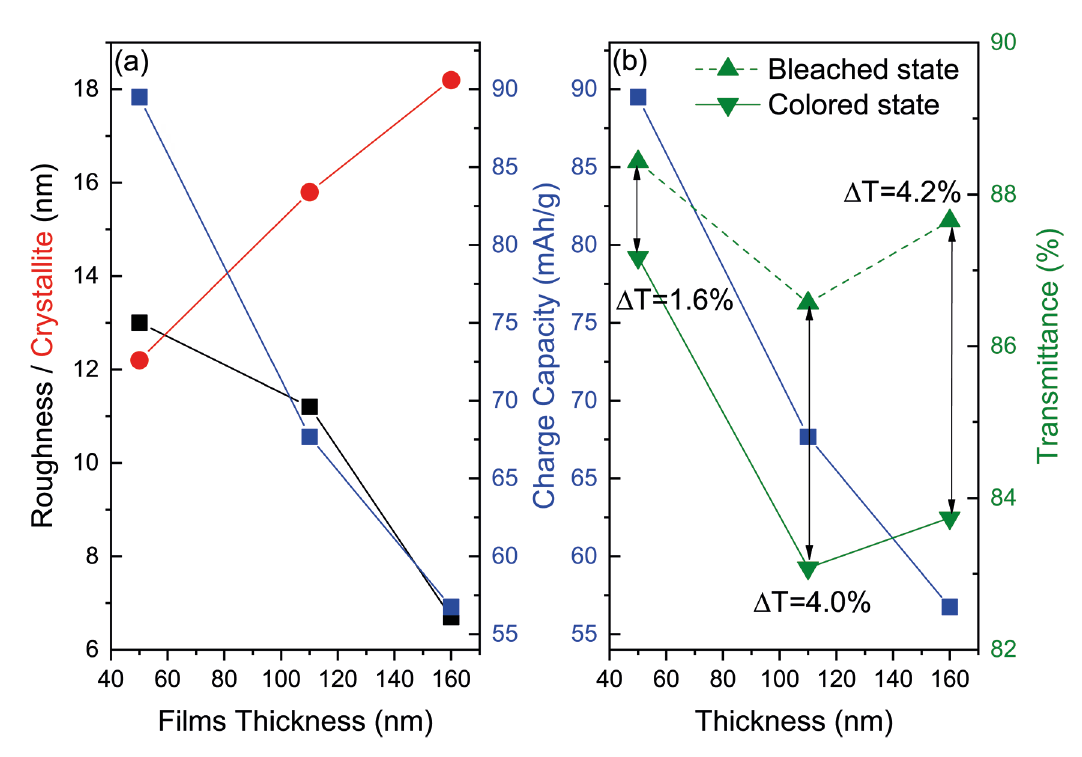
Figure 10. (a) The correlation between the crystallite size, the roughness, and the charge capacity, versus the thickness of the films. (b) The transmittance, in bleached and dark states versus the film